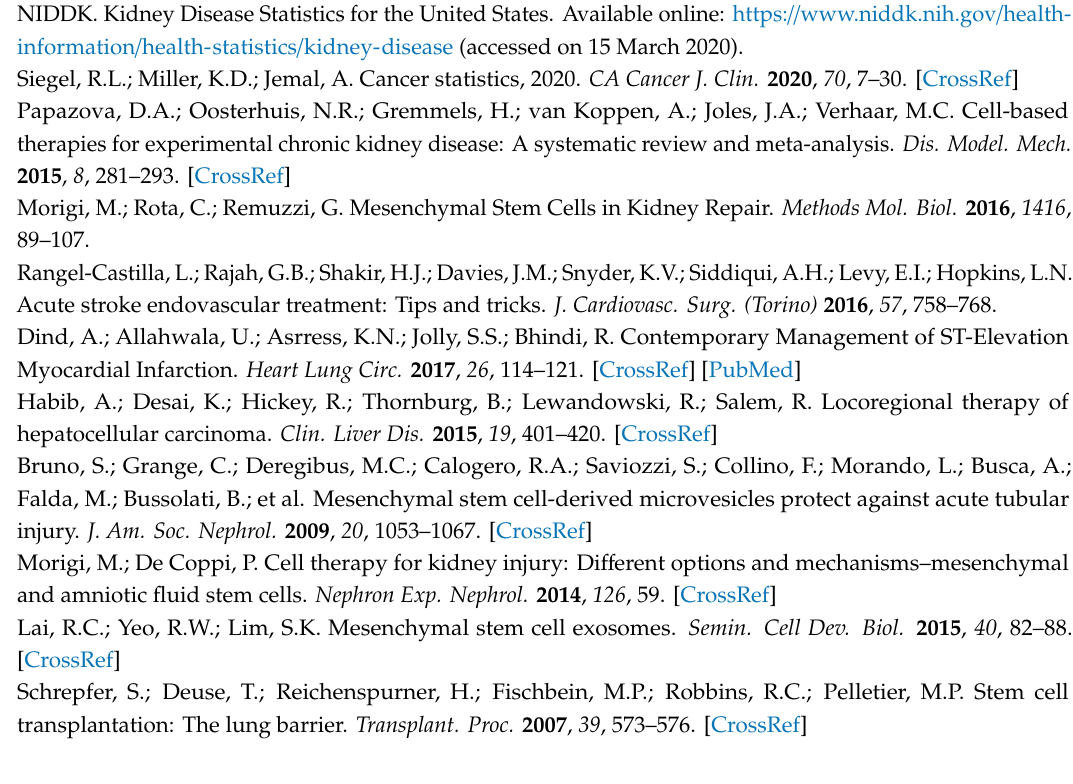
Figure S1: Exosome